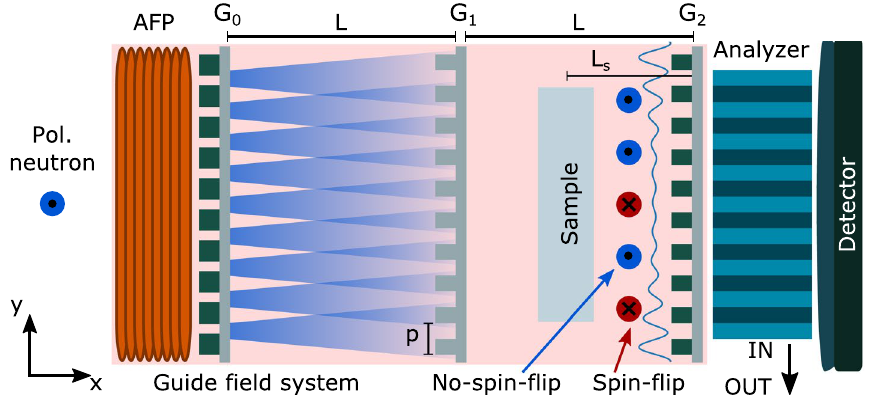
Figure 1. Schematic of the symmetric Talbot–Lau polarized neutron grating interferometer setup including the optional polarization analyzer. The setup consists of an adiabatic fast passage spin flipper (AFP), a source grating ( G 0 ) , a phase grating ( G 1 ) , an analyzer grating ( G 2 , a polarization analyzer, a neutron detector and a guide field system (shaded pink). The spin analyzer can be moved out of the beam to the side, i.e. along the y-direction (IN and OUT). The probed polarization direction is along the z-axis. The magnetic sample is placed between G 1 and G 2 at a distance L s from the latter one and moved along the x-axis direction to perform a correlation length scan. The inter-grating distance in a symmetric setup are equal to L and all periods are same ( p ). In the sketch the spin-flip and non-spin-flip small-angle scattering events are highlighted